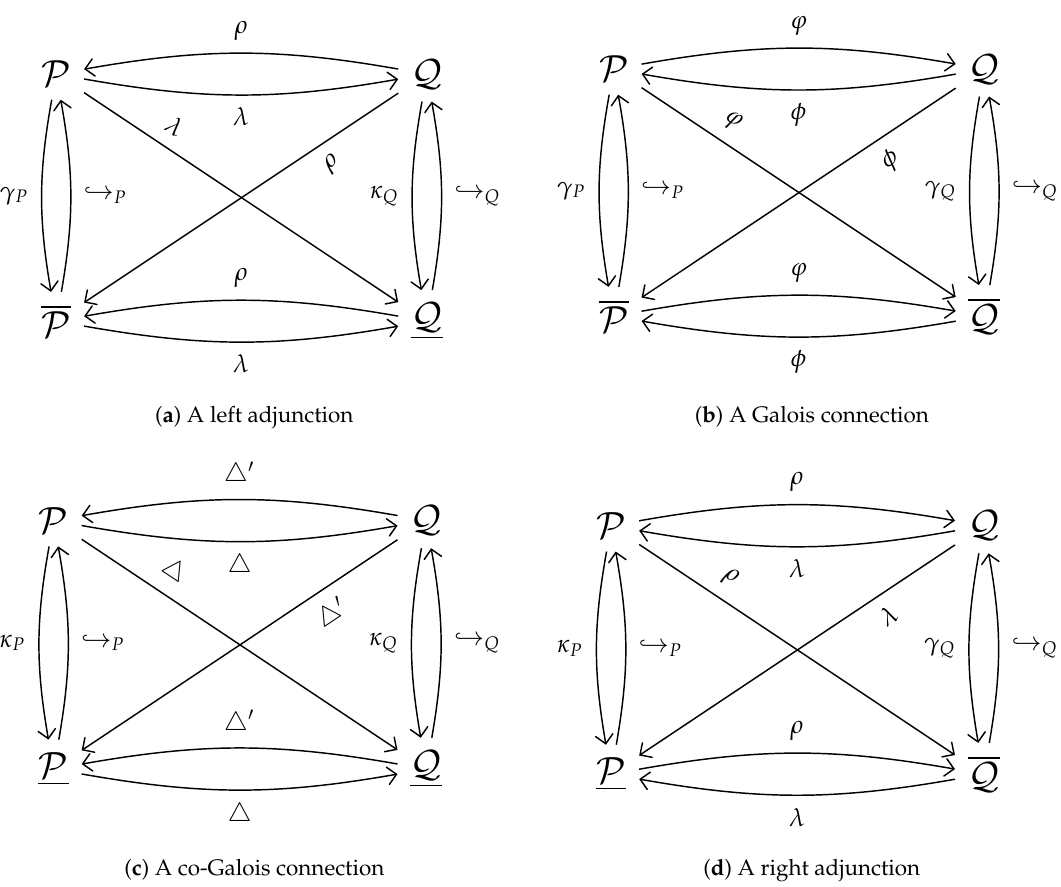
Figure A2. Diagrams visually depicting the maps and structures involved in the adjunction on the left ( λ , ρ ) : P (cid:11) Q ( a ), Galois connection ( ϕ , ψ ) : P (cid:40)(cid:42) Q ( b ), the co-Galois connection ( (cid:52) , (cid:52) (cid:48) ) : P (cid:43)(cid:41) Q ( c ) and the adjunction on the right ( ρ , λ ) : P (cid:10) Q ( d ) between two partially ordered sets (adapted from [29]). Closure operators are denoted by γ P , γ Q , interior (kernel) operators by κ P , κ Q , closure systems by P , Q and interior (kernel) systems by P , Q